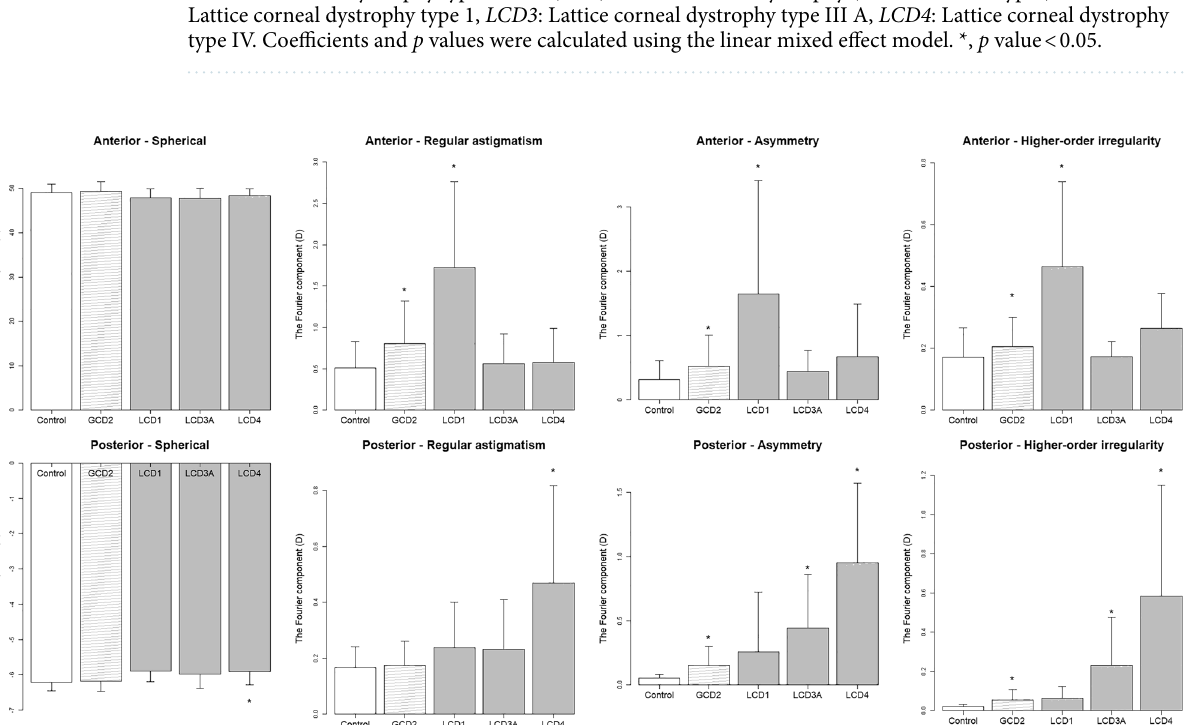
Table 3. Association between BCVA and Fourier components. BCVA : Best-corrected visual acuity, GCD2 : Granular corneal dystrophy type 2, LCD (total) : Lattice corneal dystrophy (Includes all subtypes), LCD1 :